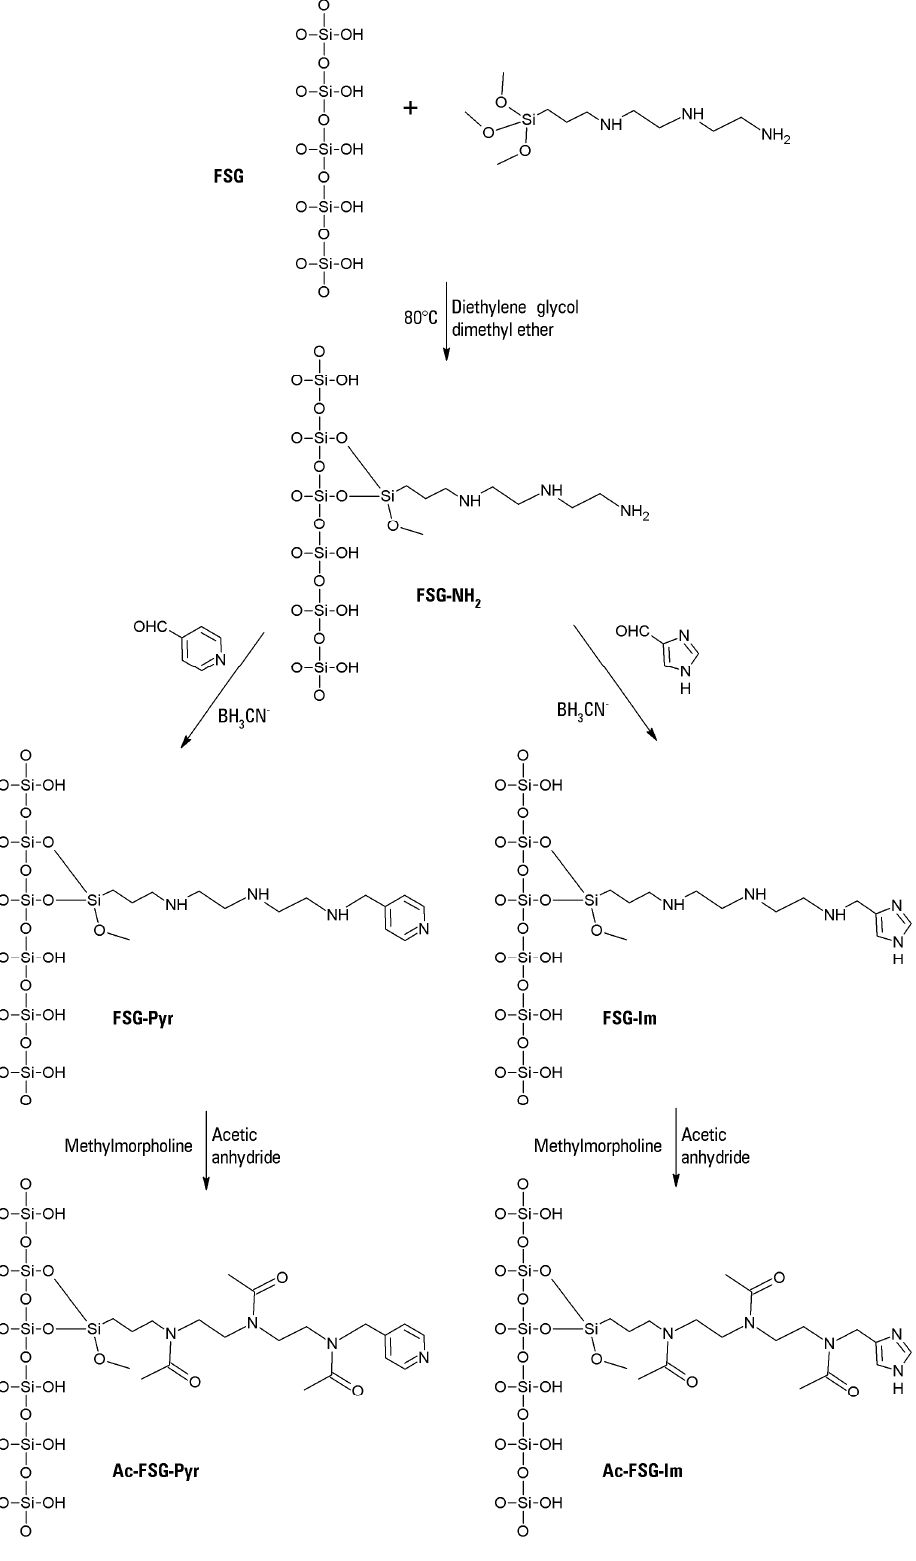
Figure 5. Putative structures of the four supports used in this study. Fumed Silica (FSG); Amine-grafted FSG (FSG-NH 2 ); Pyridine-grafted fumed silica (FSG-Pyr); Imidazole-grafted fumed silica (FSG-Im); Acetylated FSG-Pyr (Ac-FSG-Pyr); Acetylated FSG-Im (Ac-FSG-Im).